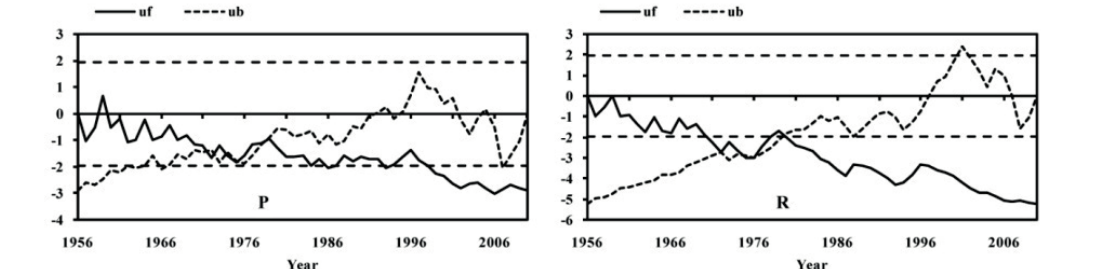
Fig. 5 Mann-Kendall’s testing statistics values of annual precipitation (P) and observed annual streamflow (R) for the whole study area (1956–2010). uf indicates the forward trend, and ub the backward